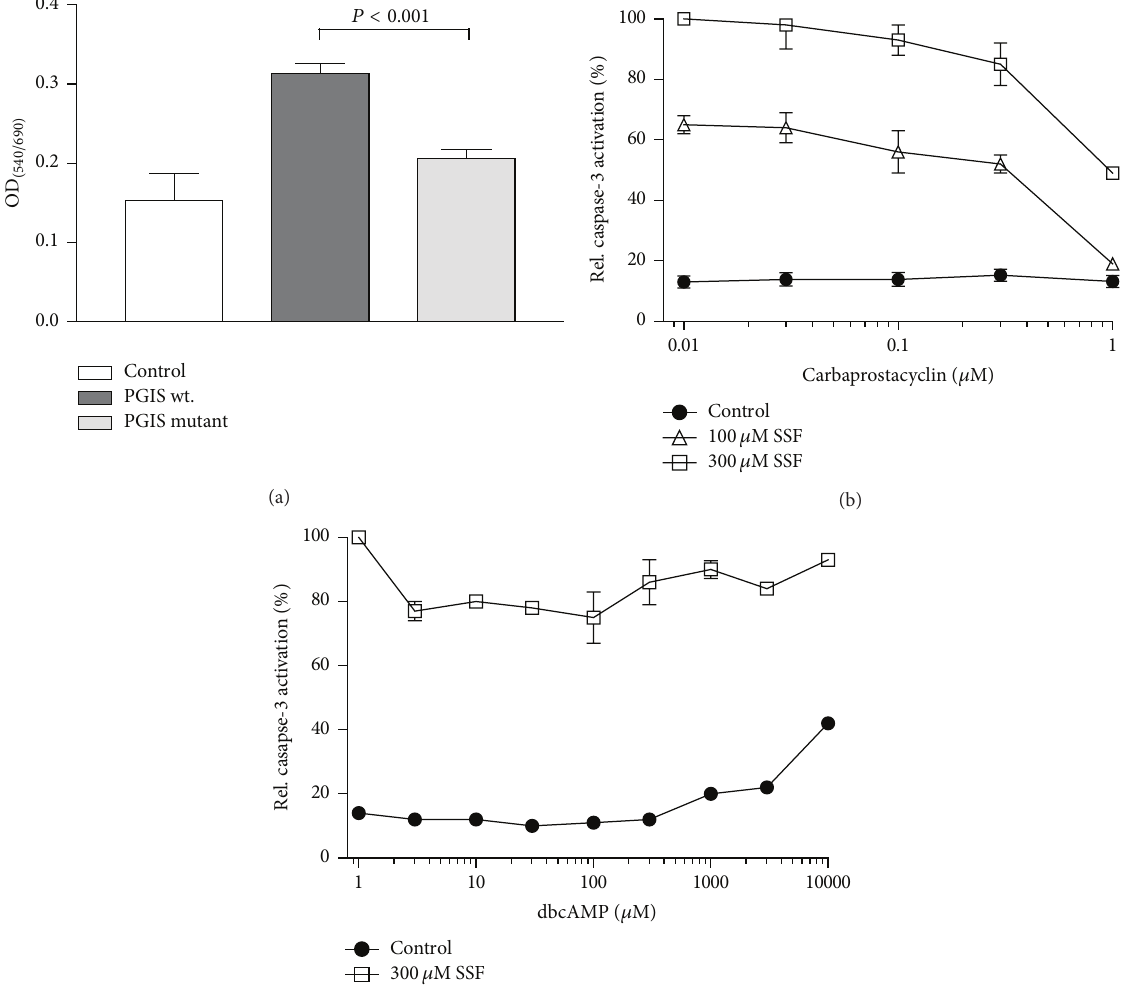
Figure 3: Effects of overexpression of PGIS and carbaprostacyclin on cell survival. (a) MCF-7 cells were transiently cotransfected with pCDNA3.1COX-2, together with control vector pCDNA3.1, pCDNA3.1mPGIS, and pCDNA3.1mPGISC441A. Cell viability upon exposure to 150 𝜇 M sulindac for 24 hours was examined by the MTT assay as compared to vehicle-treated controls (0.1% DMSO). ((b), (c)) Carbaprostacyclin-mediated protection from sulindac sulfone-induced apoptosis. CCRF-CEM cells were treated with 0, 100, and 300 𝜇 M sulindac sulfone in the presence of (b) 0.01–1 𝜇 M carbaprostacyclin or (c) 0.001–10 mM dbcAMP. 24 hours posttreatment caspase-3 activity was measured by cleavage of fluorogenic substrate